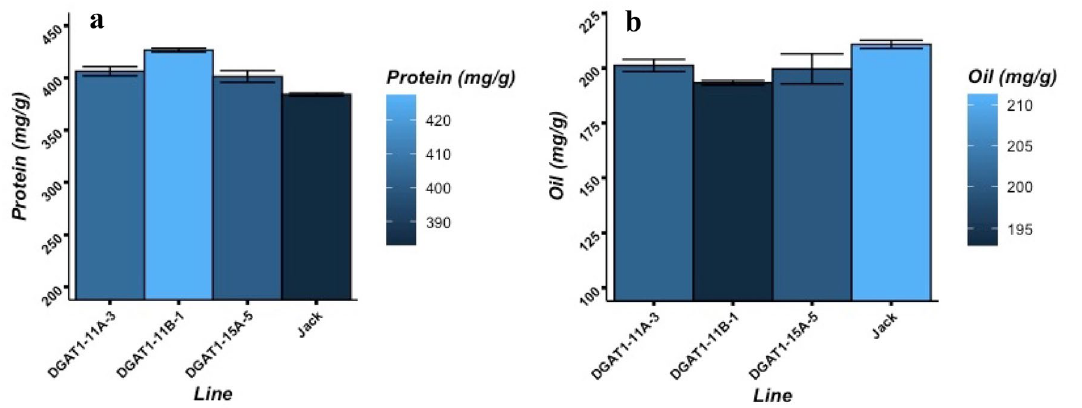
Figure 5. Seeds protein and oil concentrations in transgenic lines and wild type (cv. Jack). ( a ) Seed protein accumulation (mg/g). ( b ) Seed oil accumulation (mg/g). The presented values are mean ± SE measured using three independent